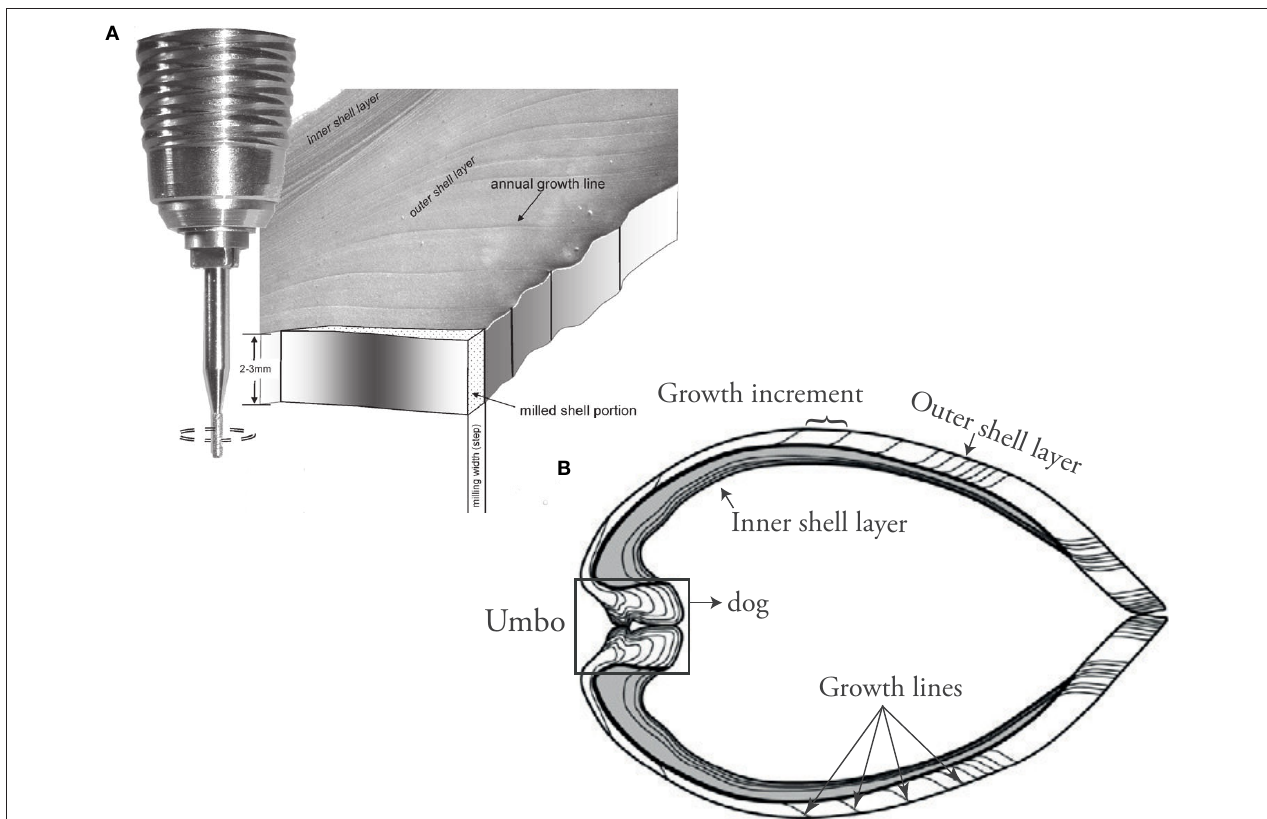
FIGURE 5 | (A) Micromill sampling from shell carbonate for isotope analysis and Element/Ca ICP-MS wet chemistry (Figure from Schöne et al., 2005b). (B) Umbo-ventral margin shell cross section showing the parts of the shell typically used for geochemical analysis in sclerochronology.